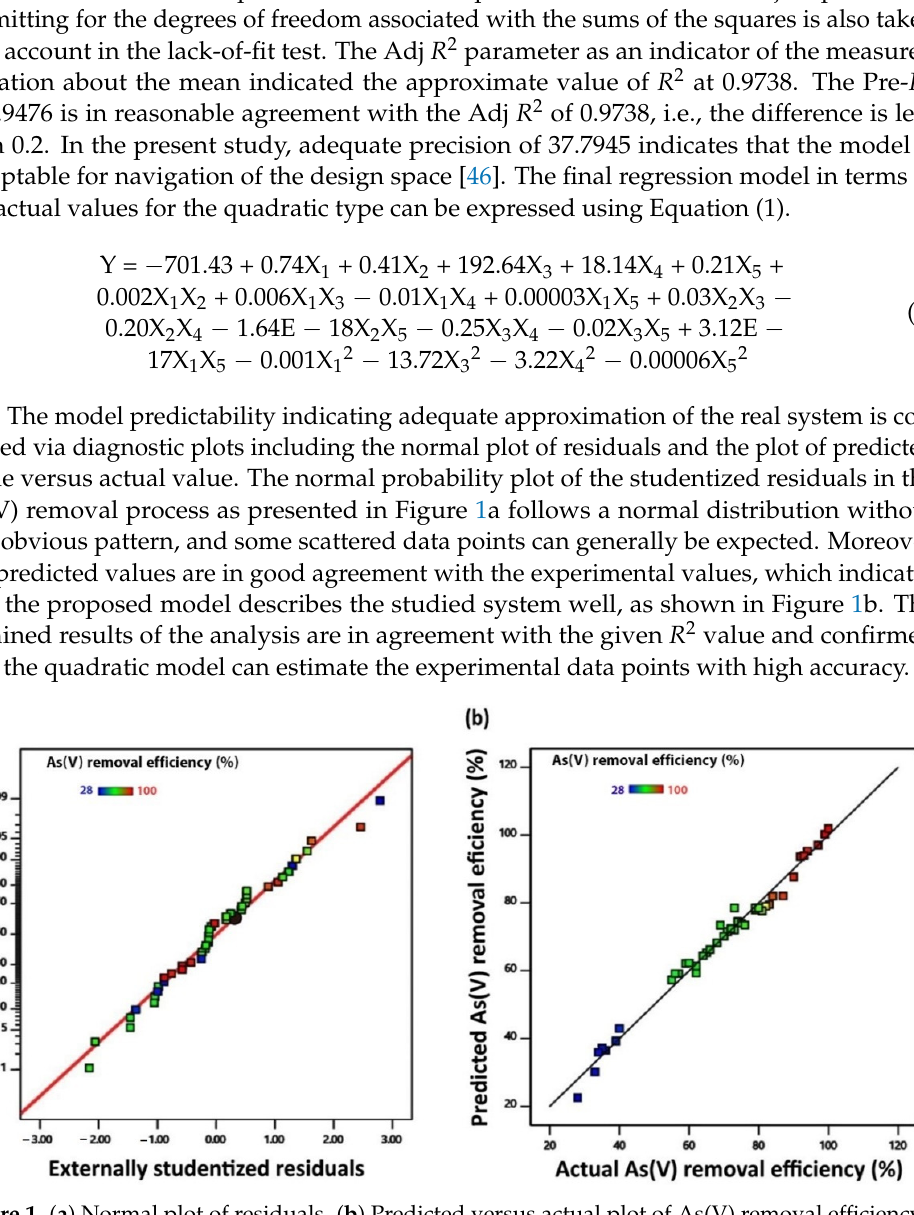
Figure 1. ( a ) Normal plot of residuals. ( b ) Predicted versus actual plot of As(V) removal efficiency. 2.3. Three-Dimensional Surface and Two-Dimensional Contour Plots of As(V) Removal A three-dimensional (3D) response surface plot displays the function of two factors on the response, while all the other factors remain unchanged at zero-level values. Thus, the main effects, as well as the interaction effects of the two factors, can be investigated. In addition to 3D plots, contour maps can indicate the influence of the design parameters on the response. Therefore, the influence of the experimental variables on the As(V) removal efficiency was studied by the generation of 3D response surface plots and contour maps based on the model equation. Figure 2a,b displays the 3D response surface plot and contour map of coagulant dosing (A) and co-coagulant dosing (B) factors at zero-level values of pH (C), fast mixing time (D), and fast mixing speed (E) factors. Coagulant dosing